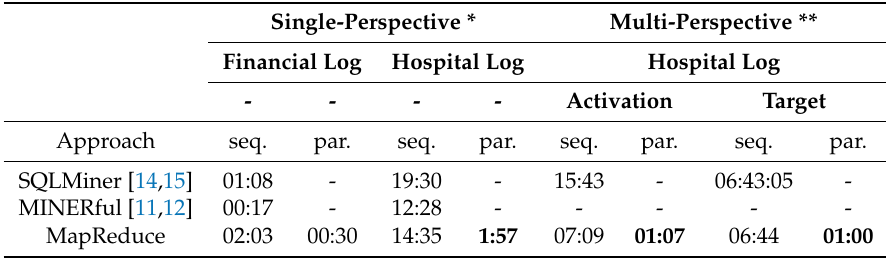
Table 21. Performance evaluation with related